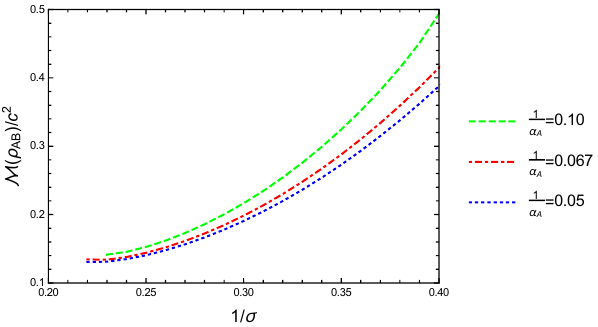
Figure 19 . In (1 + 1) dimensions the quantity M ( ρ AB ) /c 2 per unit proper time is plotted, which signifies the mutual information, for two parallelly accelerating detectors with respect to the tem- perature of the thermal field T ( f ) ( ∼ 1 /σ ) for different fixed proper accelerations α